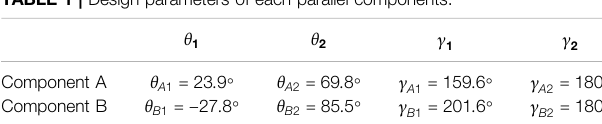
TABLE 1 | Design parameters of each parallel